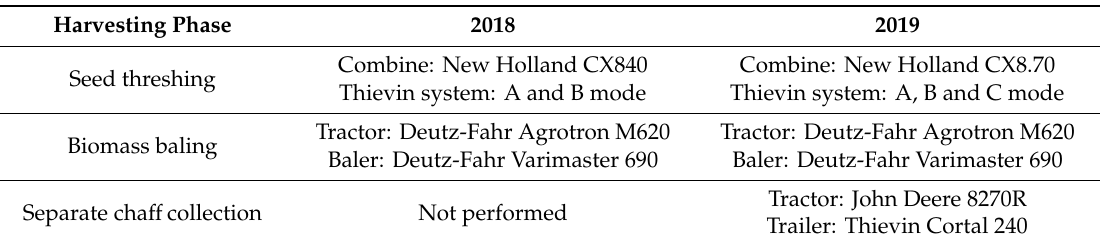
Table 1. Equipment used during the tests.